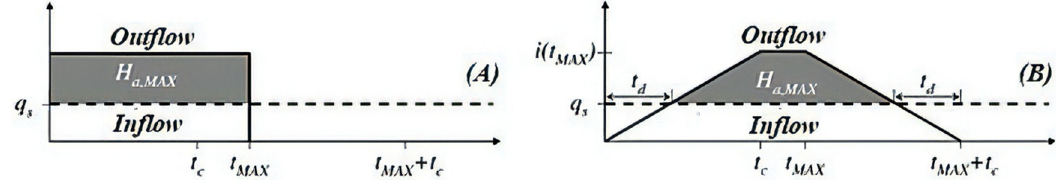
Figure 4. ( A ) Dutch method; ( B ) STH method (Source: